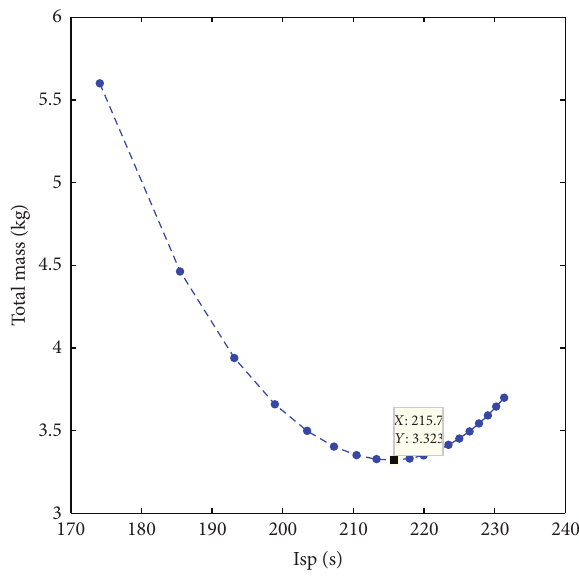
Figure 10: Total mass variation with Isp.